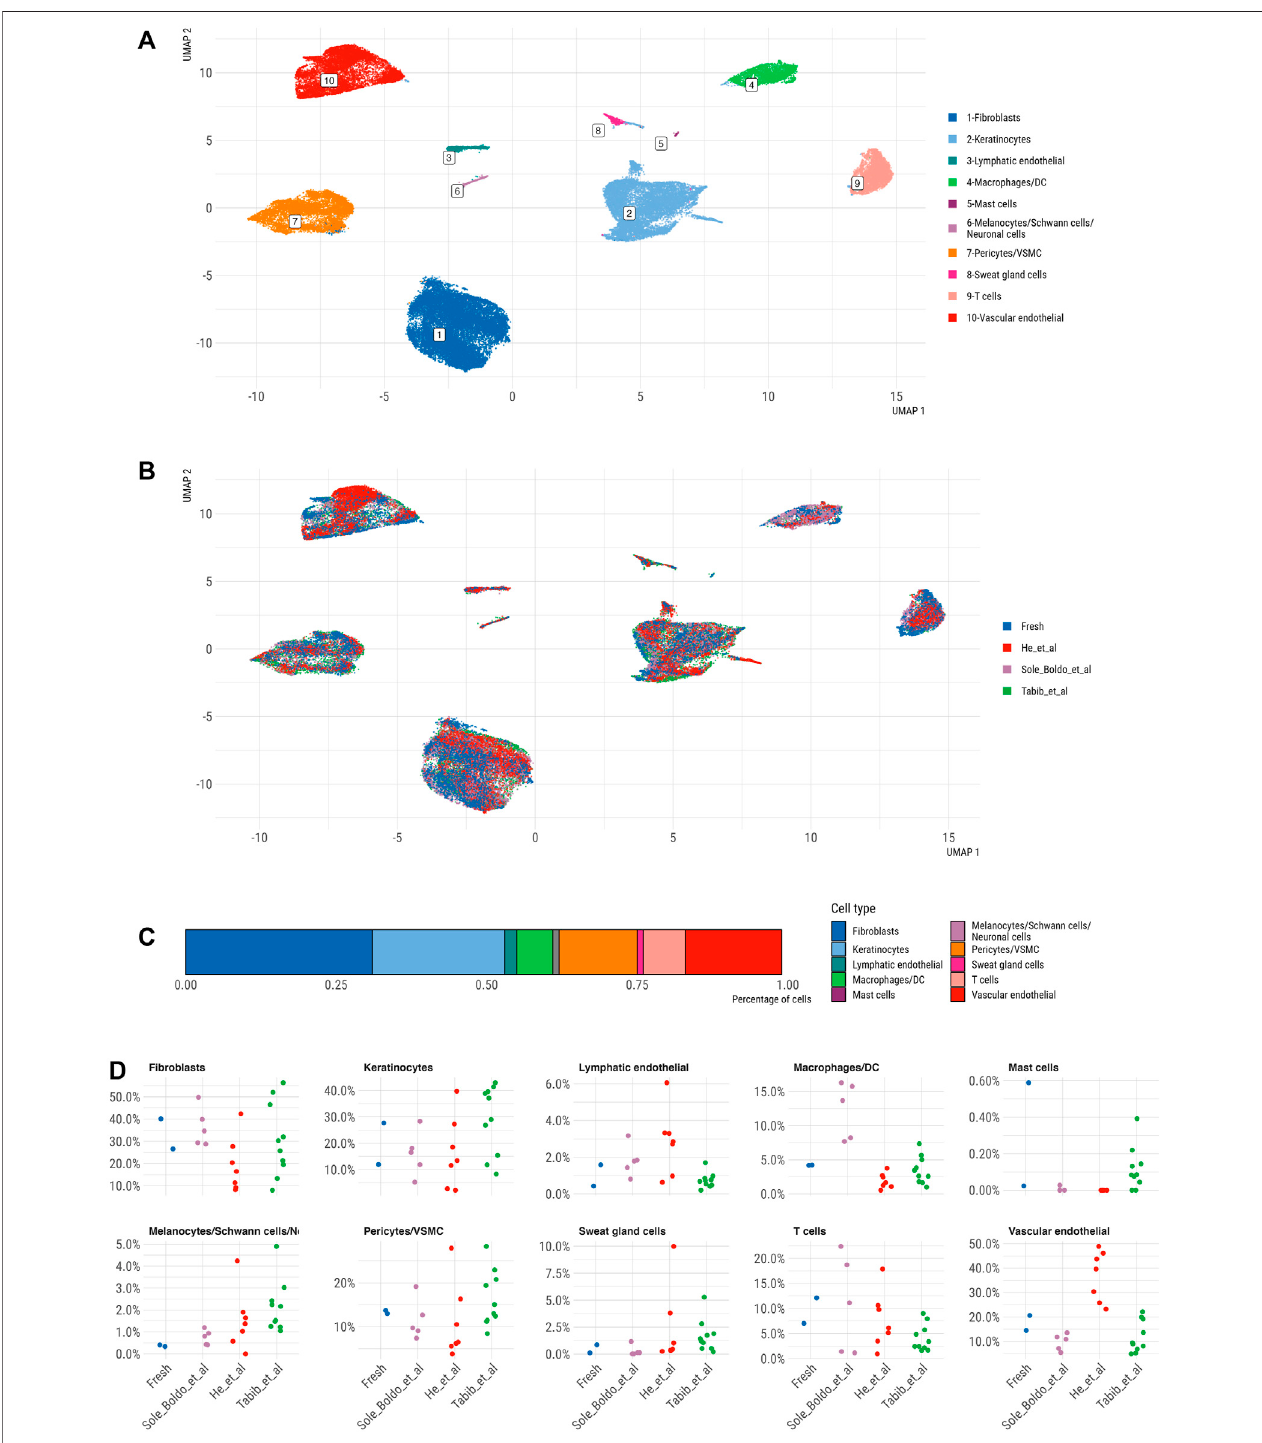
FIGURE 5 | UMAP representation of integrated skin scRNA-seq datasets, coloured by (A) main cell type and (B) by dataset. (C) Bar plot showing relative abundance of cell type distribution across integrated dataset (D) Jitter strip plot showing relative abundance of cell types across all differerent datasets.